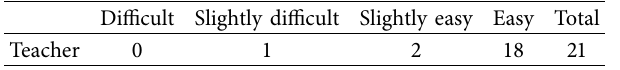
Table 1: Ease of use of the ELORS scale by the